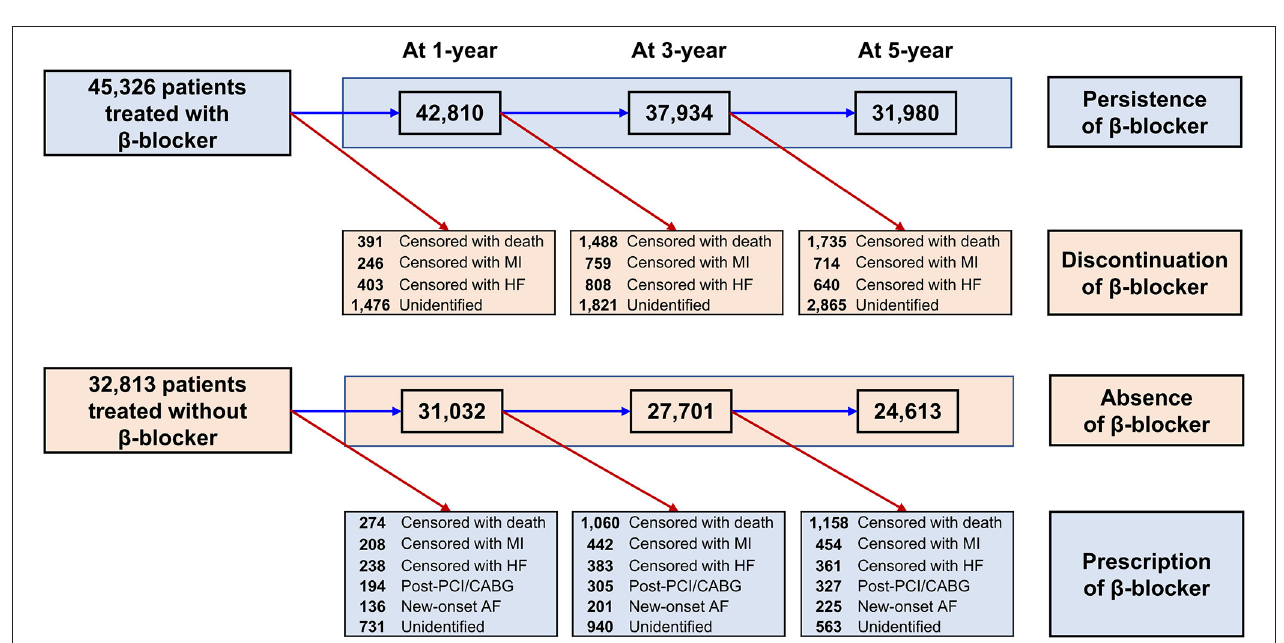
FIGURE 3 | Subgroup analysis for major adverse cardiovascular events. Numbers and percentages show the number of patients at risk, number of events, and the incidence rate of major adverse cardiac events 5 years after drug-eluting stent implantation. CI, confidence interval; CVA, cerebrovascular accidents; MACE, major adverse cardiovascular events.